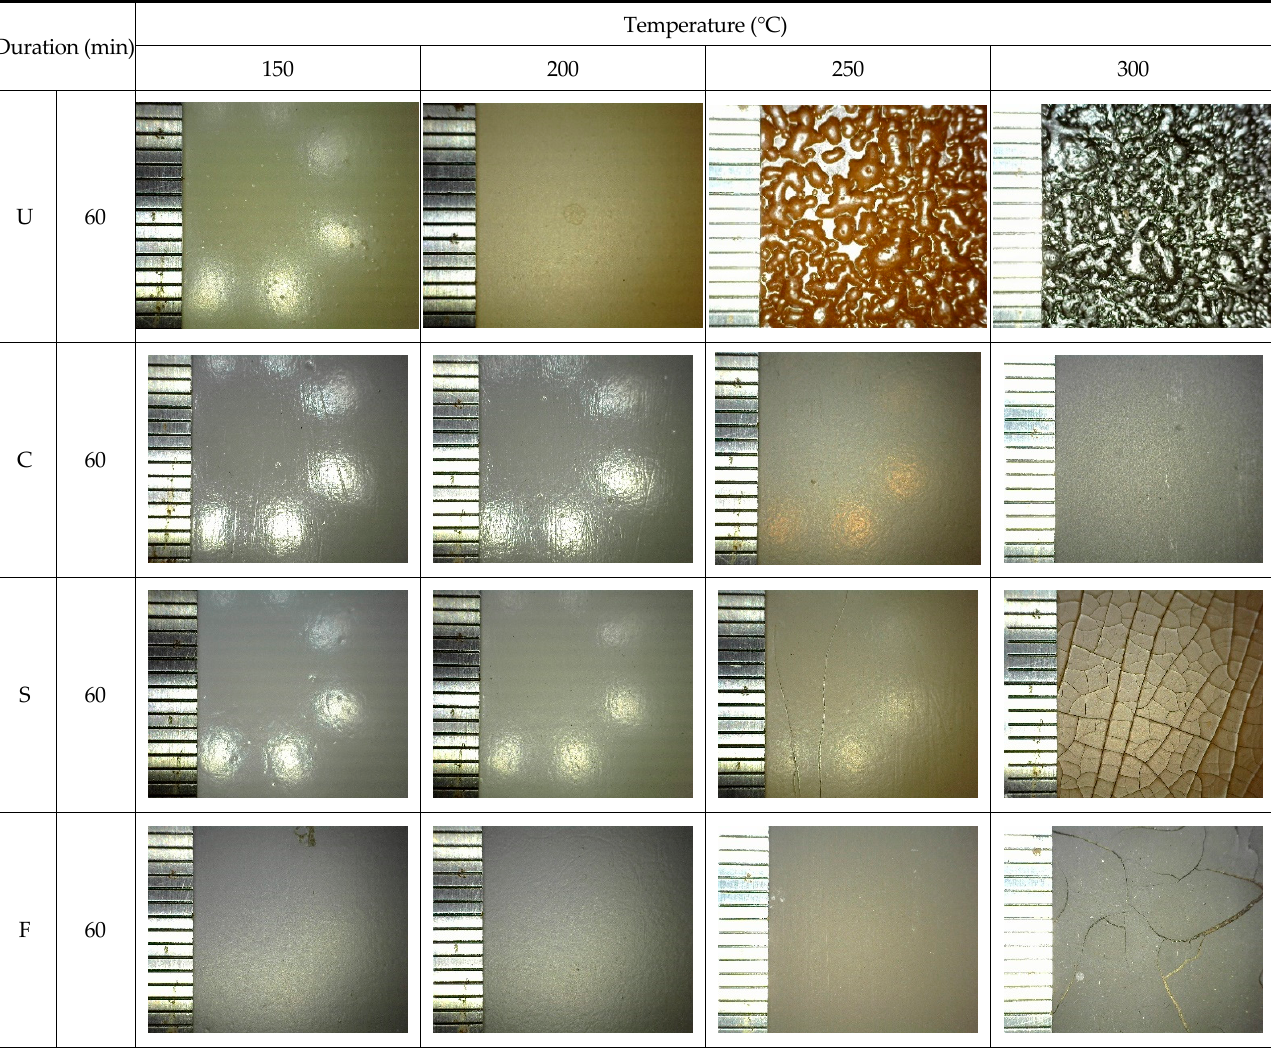
Figure 4. Magnified surface conditions (20×).